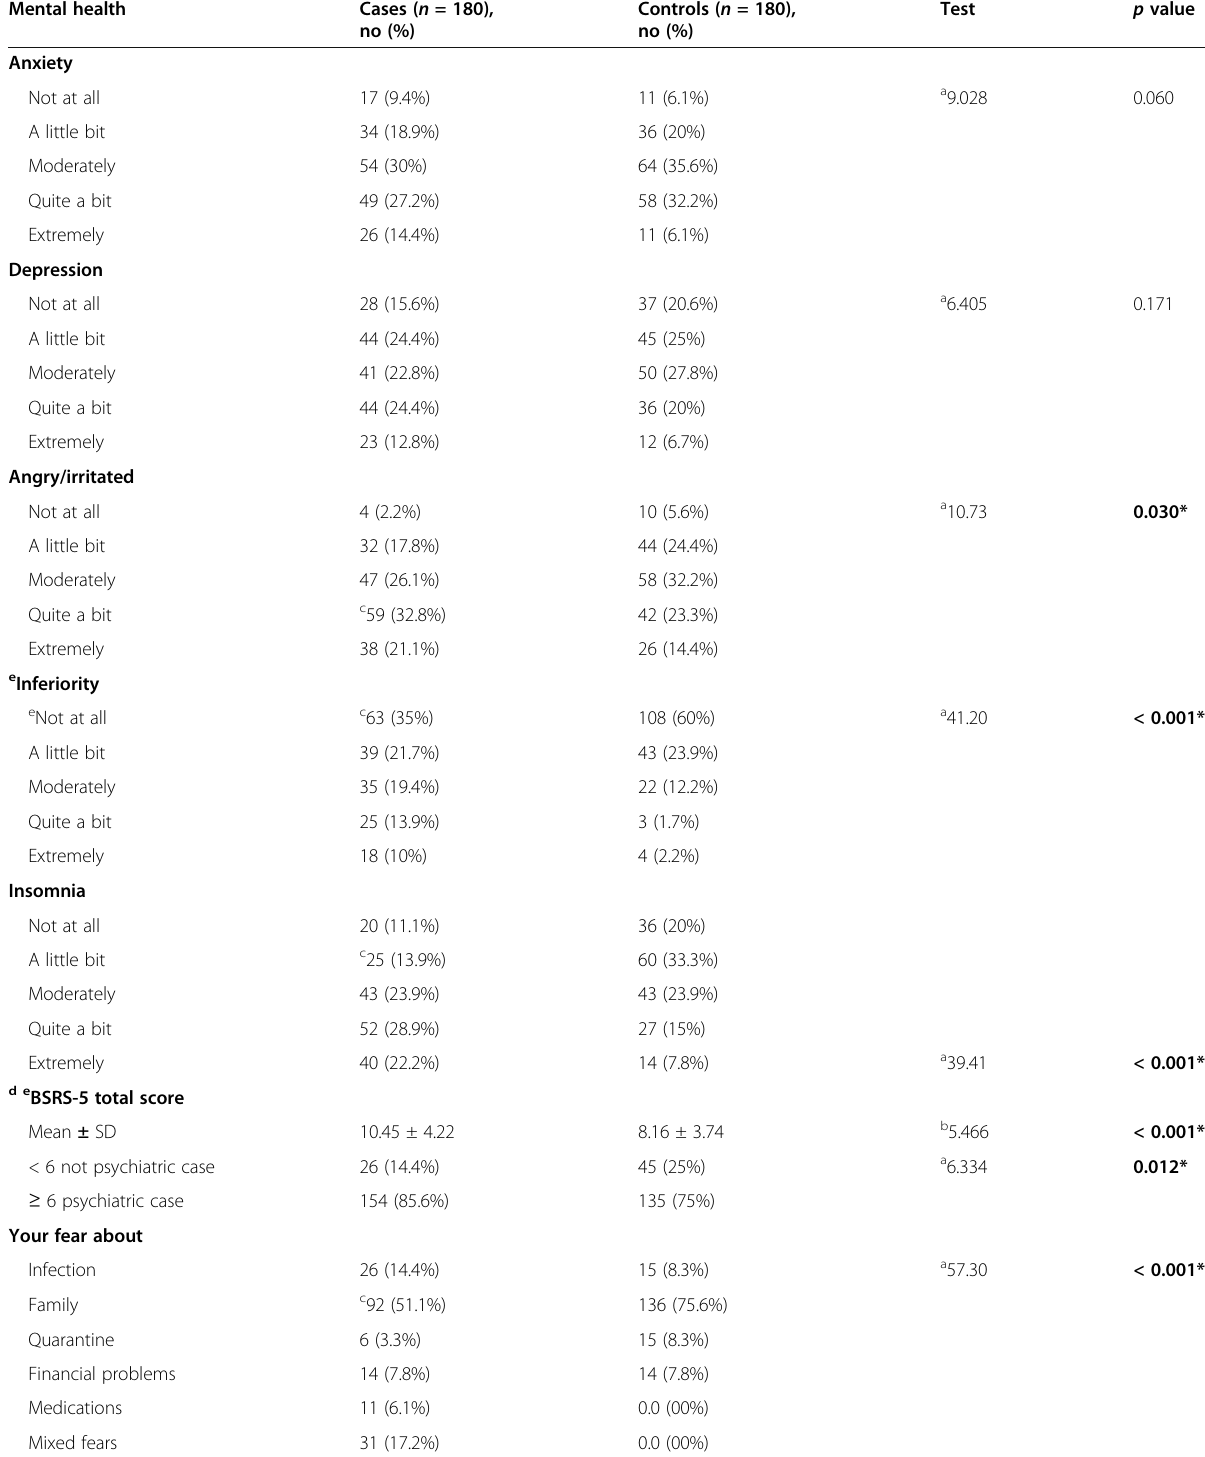
Table 3 Mental health comparison among the studied groups ( n =